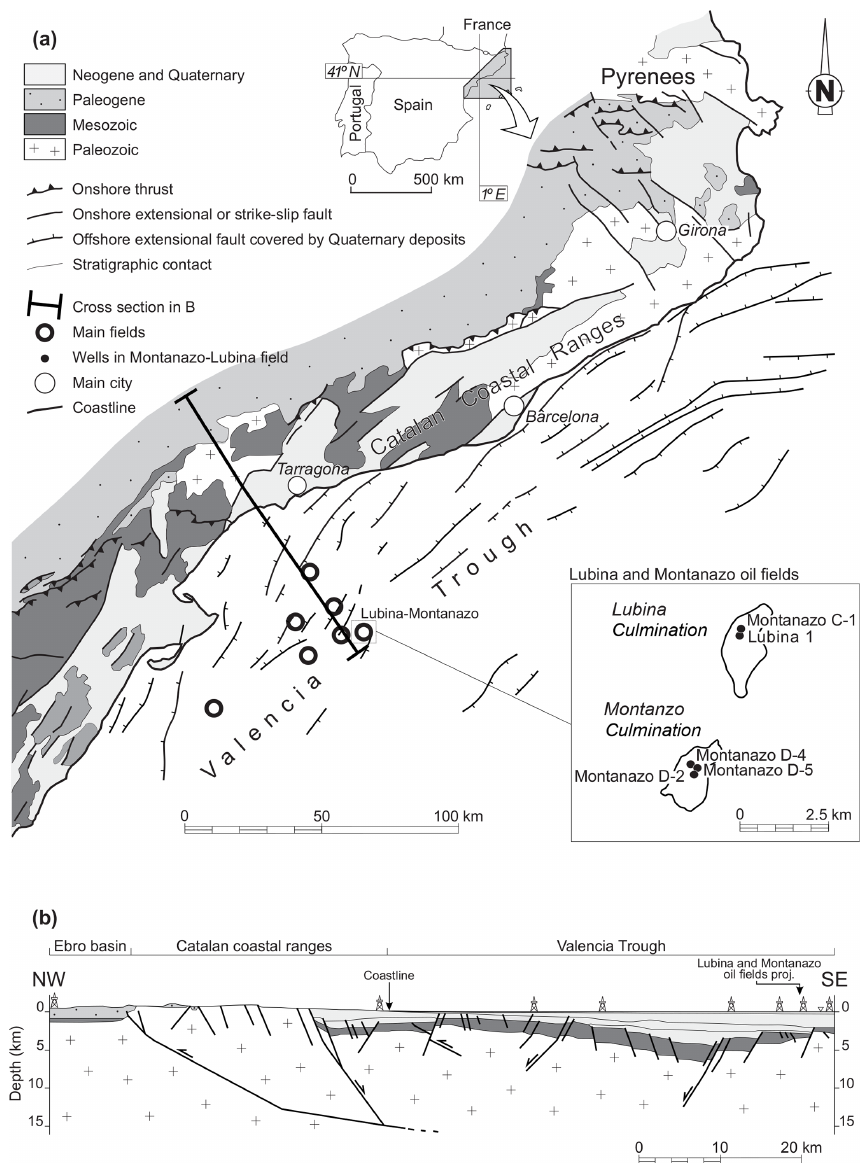
Figure 1. (a) Geological map of the northeastern part of the Iberian Peninsula showing the location of the Lubina and Montanazo oil fields. The Montanazo culmination forms the southwestern part of the field where Montanazo D-2, Montanazo D-4 and Montanazo D-5 wells were drilled. The Lubina culmination corresponds to the northeastern part and has the Montanazo C-1 and Lubina 1 wells. Modified from Roca (1994) and Roca et al. (1999). (b) Regional cross section from the Ebro basin to the Valencia Trough located a few kilometers south of Lubina and Montanazo oil fields. Modified from Cabrera et al.